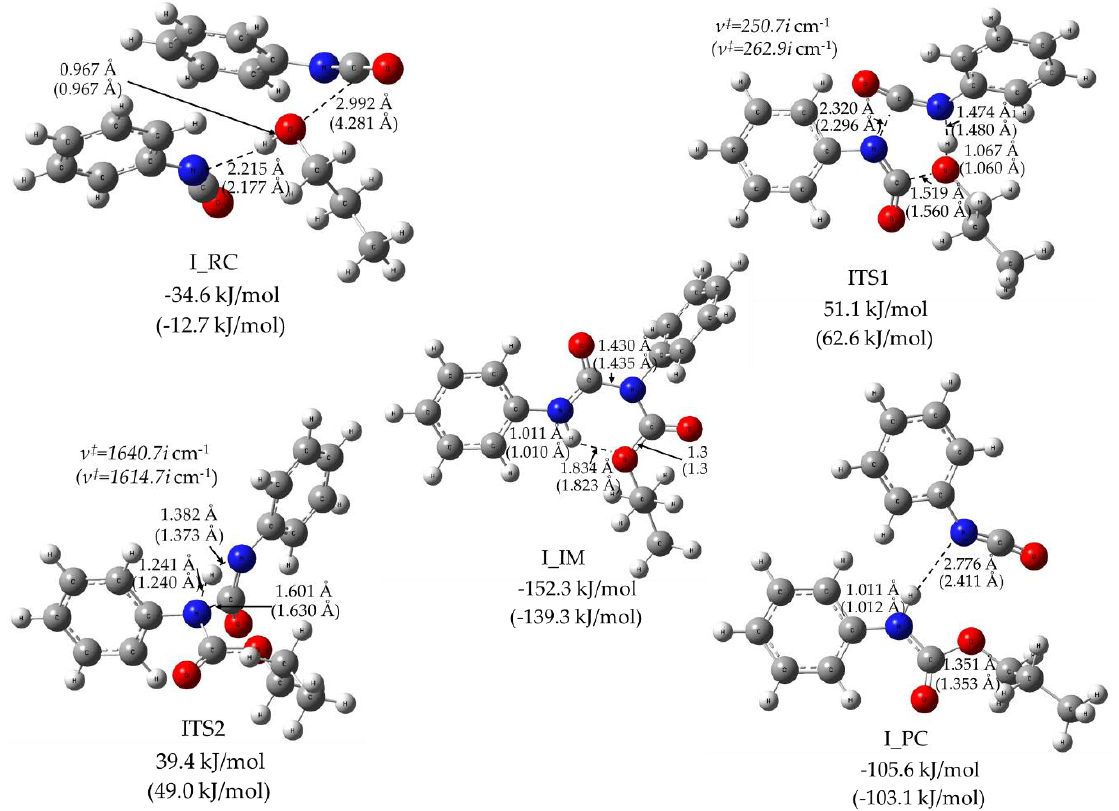
Figure 5. Reactive complex (RC), transition state structure (TS), intermediate (IM) and product complex (PC) structures (obtained at the B3LYP/6 31G(2df,p) level of theory from the G4MP2 calculation) for the isocyanate excess reaction mechanism of urethane bond formation in solvent 1-PrOH or THF (in parenthesis). The relative zero-point corrected energies are also presented in kJ/mol. As IRC calculation started from ITS1 confirmed, I_RC and I_IM are connected through